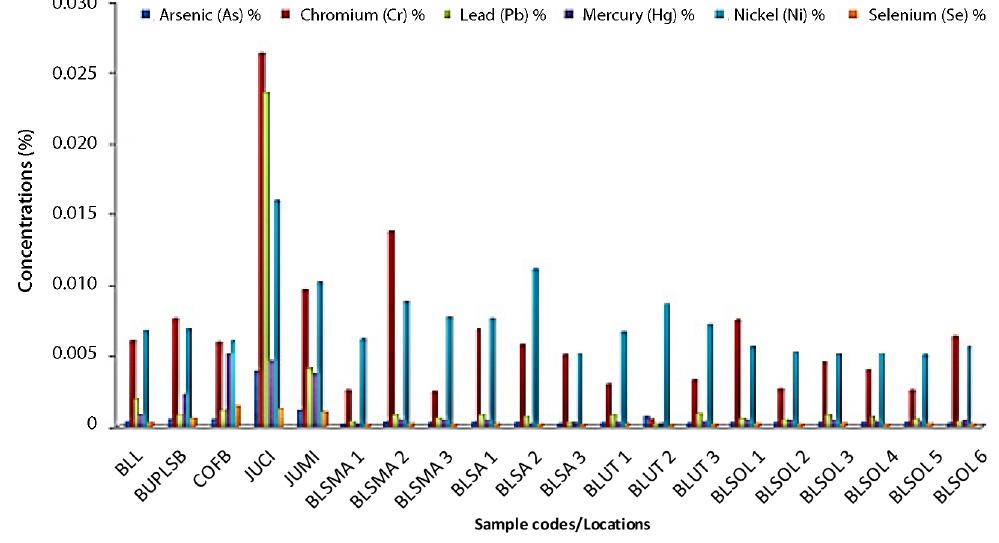
Figure 3. Concentrations of heavy metals (% by weight) in ash samples from ignited plant